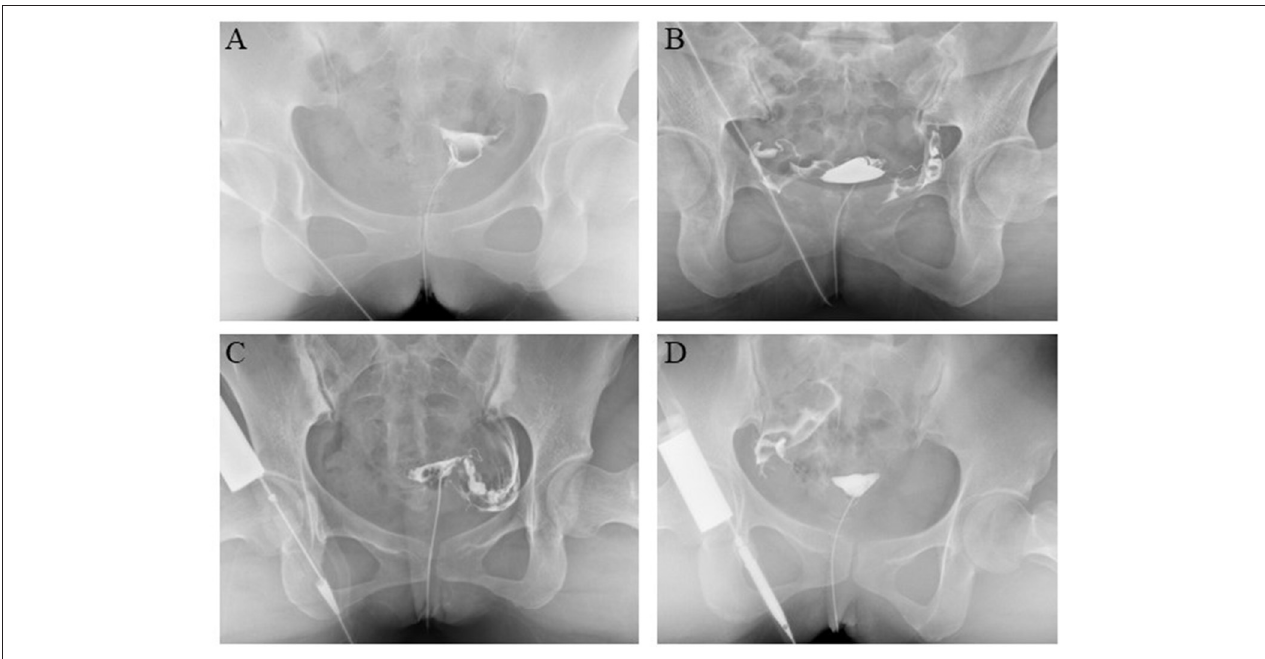
FIGURE 1 | Diagnosis of fallopian tube patency or occlusion by hysterosalpingography (HSG). (A) Both fallopian tube patency. (B) Both fallopian tube occlusion. (C) Left tube patency and right tube occlusion. (D) Right tube patency and left tube occlusion.